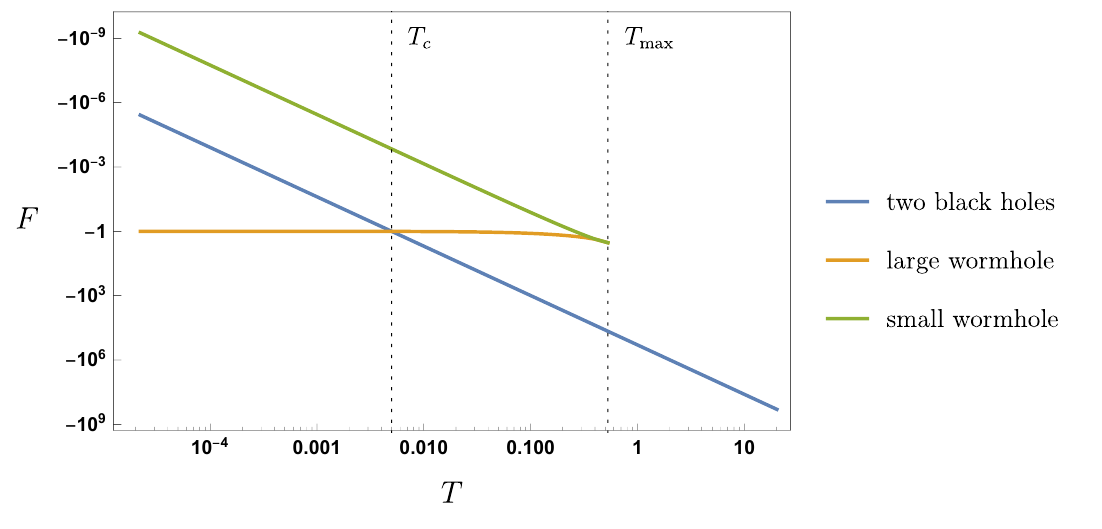
Figure 6 . Log-log plot of the free energy. We observe a phase transition at T = T c from a disconnected phase with two black holes to the connected wormhole phase. The plot is done using Λ 0 = 1 and S 0 = 10 2 .